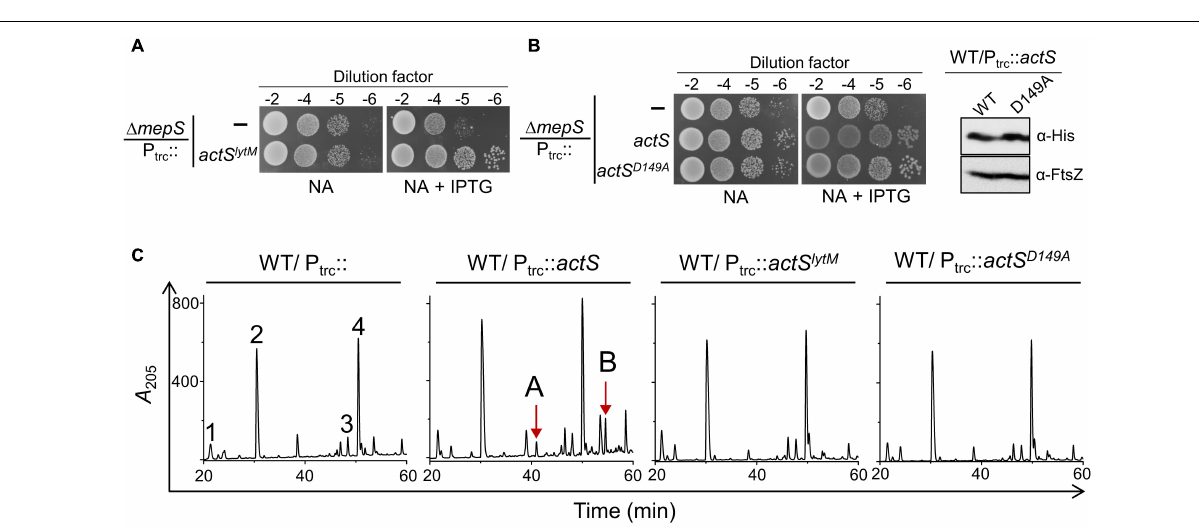
FIGURE 6 | Alleviation of (cid:49) mepS growth defects by ActS is not mediated by AmiC. Indicated strains carrying empty vector (P trc ::) or vector encoding actS (P trc :: actS ) were subjected to viability assay on NA plates with (20 µ M) or without IPTG. For reasons not clear, loss of AmiA or AmiC conferred a subtle growth advantage to (cid:49) mepS mutant.